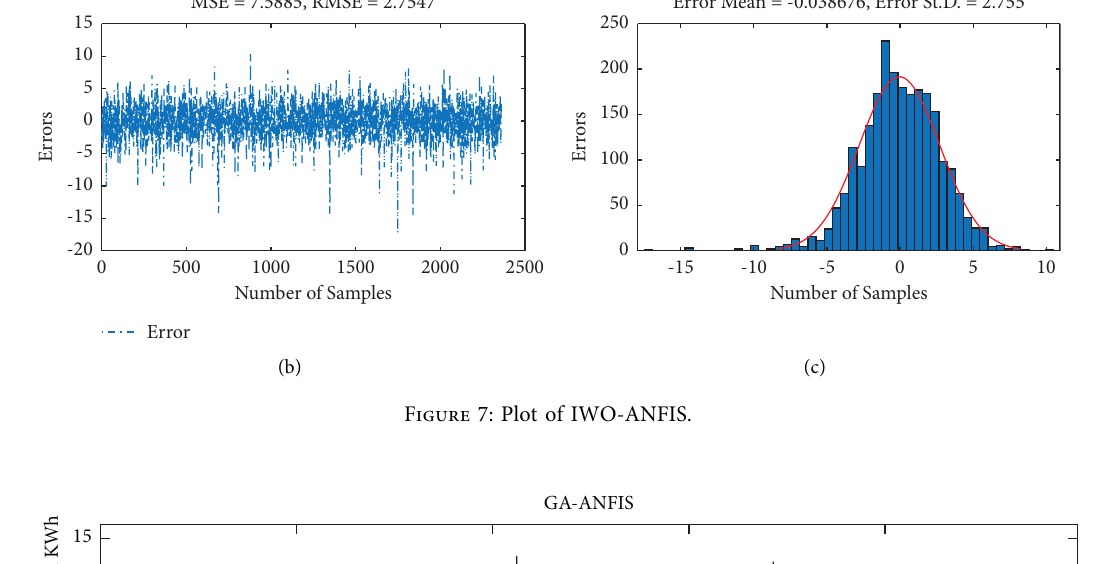
Figure 7: Plot of IWO-ANFIS.